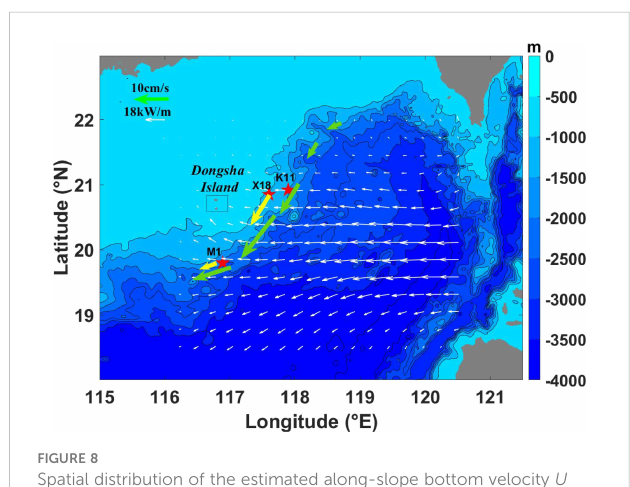
FIGURE 8 Spatial distribution of the estimated along-slope bottom velocity U (green arrows) caused by breaking diurnal internal tides on the northeastern continental slope of the SCS based on the modeled dissipation of diurnal internal tides in the MITgcm simulations of Wang et al. (2021). The white arrows indicate the energy fl uxes of modeled K 1 internal tides (Wang et al. (2021)). The yellow arrows are the observed U at M1 and X18.